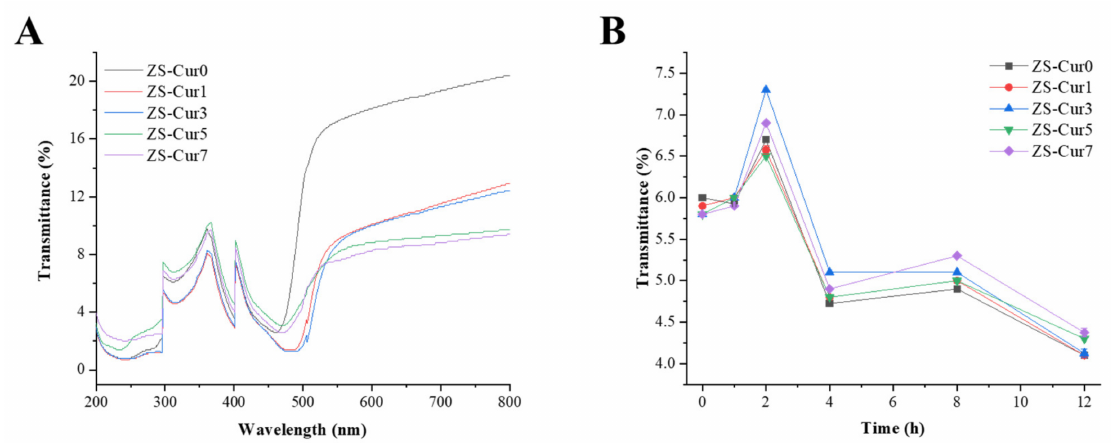
Figure 1. ( A ) UV-Vis transmittance of ZS–Cur films and ( B ) effect of prolonged UV irradiation on